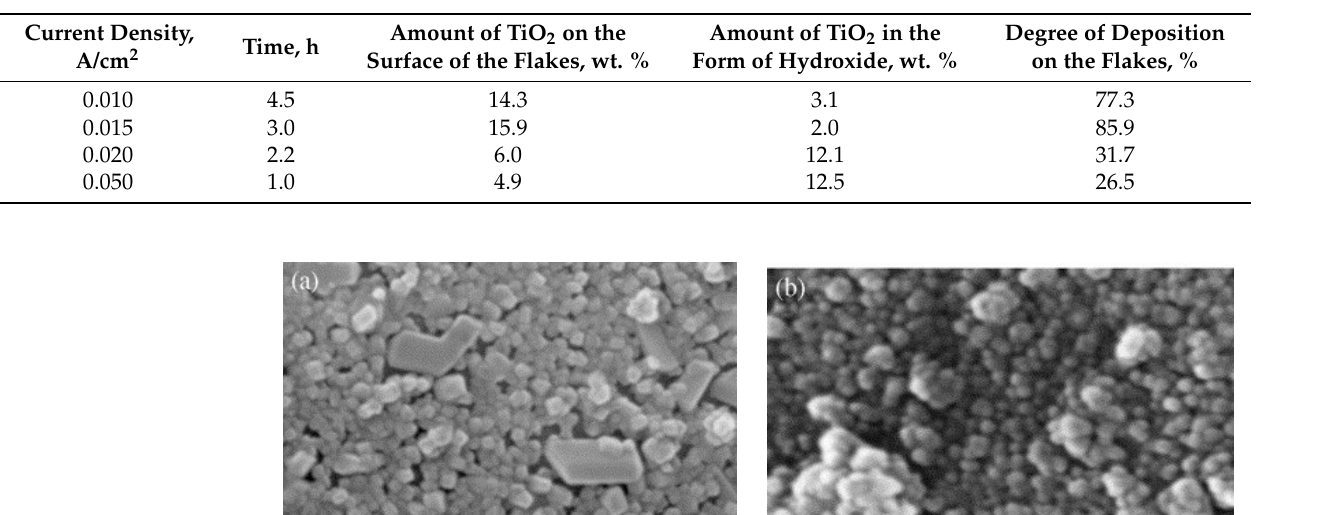
Table 2. Conditions of electrodialysis and the degree of deposition of TiO 2 on the flakes.